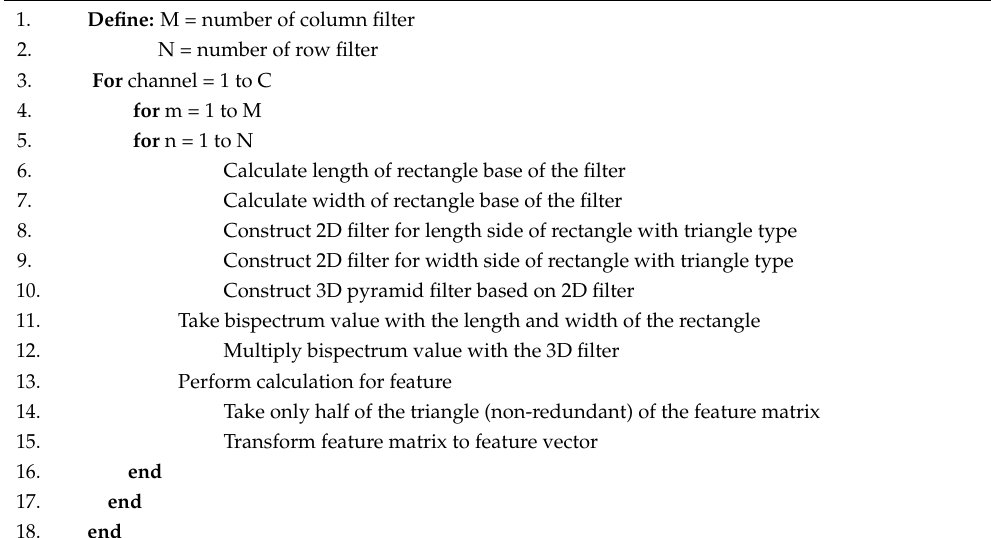
Algorithm 2: Bispectrum 3D filtering for feature extraction algorithm.